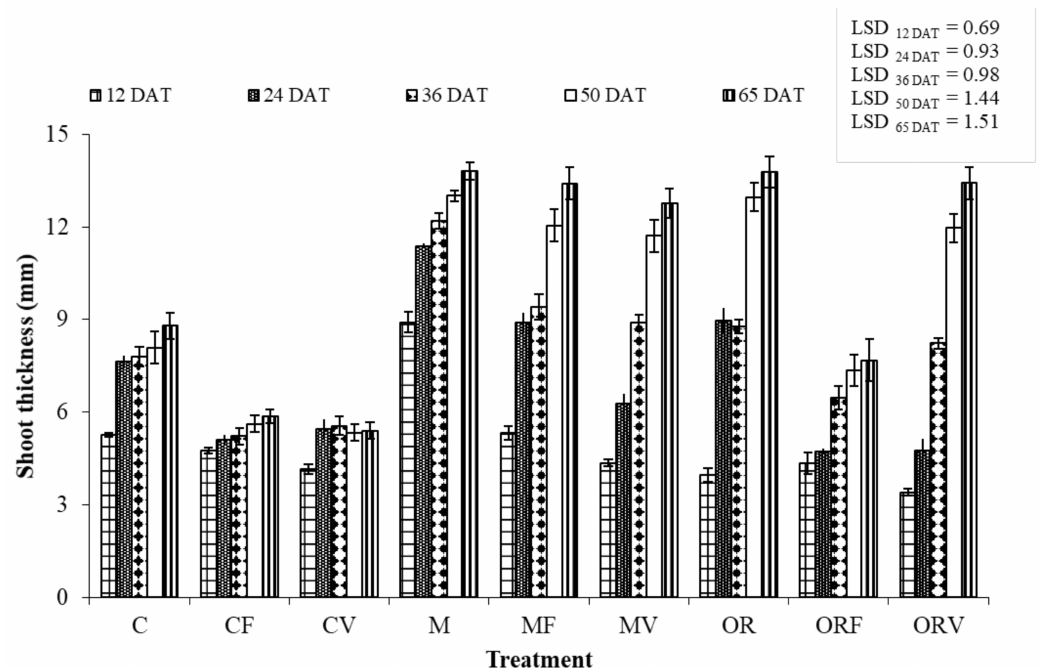
Figure 4. Shoot thickness (means ± se) of healthy and inoculated transplanted tomatoes grown in soil amended with 4% (w / w) of spearmint or oregano plant material. Determination was made at 12, 24, 36, 50 and 65 days after the transplantation (DAT), whereas each mean represents the average of 24 determinations [12 replications (plants) × 2 experiments]. Full description of the treatments examined is found in Table